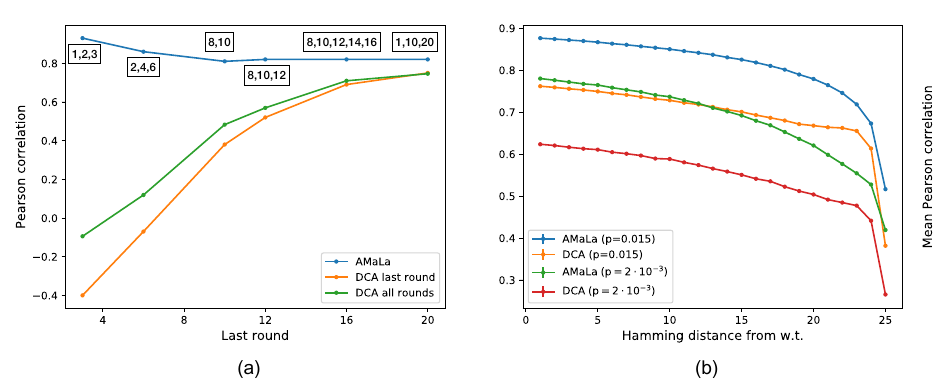
Figure 5. Inferred signal dependence on the number of rounds and hamming distance from wild- type. Left panel ( a ): Pearson correlation when the number of rounds are changing. Comparison between PlmDCA on the last round (or all rounds) and AMaLa. The sequenced rounds are: (1, 2, 3); (2, 4, 6); (8, 10); (8, 10, 12); (8, 10, 12, 14, 16); (1, 10, 20). PlmDCA significantly depends on the number of performed rounds, not significantly inferring the fitness landscape up to round contrary, AMaLa provides predicted energy functions highly correlated with the fitness even for a low number of performed selection rounds. Right panel ( b ): Degradation of the mean Pearson correlation between inferred and true energies as a function of the Hamming distance from the wild-type sequence. Two different simulations are considered: high ( p = 0.015) and low ( p = 0.002) mutation probability. Changing such parameters varies the broadness of the library screening during an experiment, resulting in probing a more local or more broad region of the sequence space. AMaLa predictions are systematically better than PlmDCA, while the latter displays a slower decrease in correlation augmenting the distance from